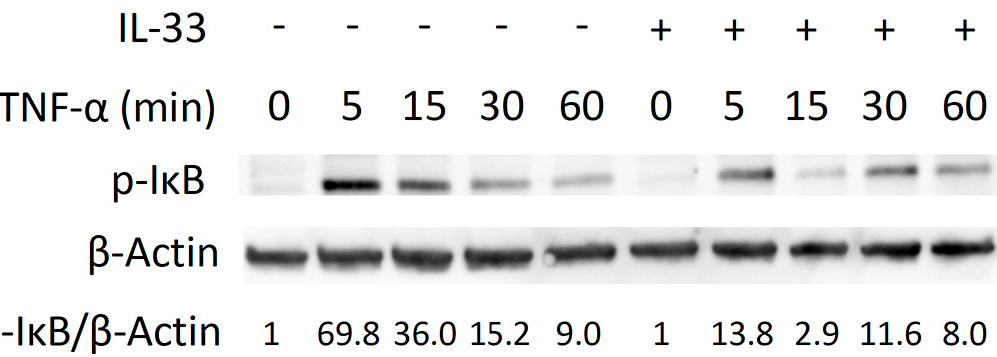
Figure 4. IL-33 inhibits I κ B phosphorylation by TNF- α . Osteoclast precursors were exposed to TNF- α or TNF- α + IL-33 for specific periods. Cells were lysed and contents analyzed by Western